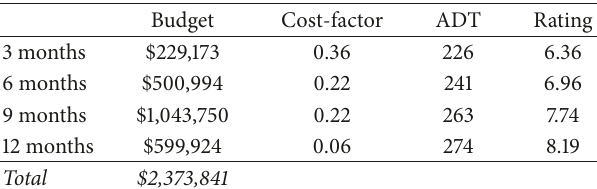
Table 6: Budgets for every 3 months associated with optimization